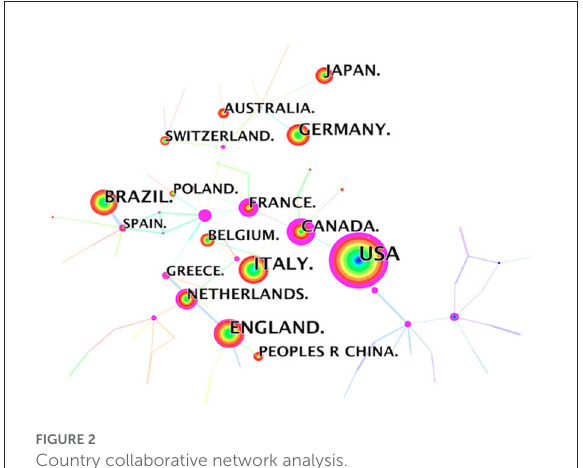
FIGURE2 Country collaborative network analysis.